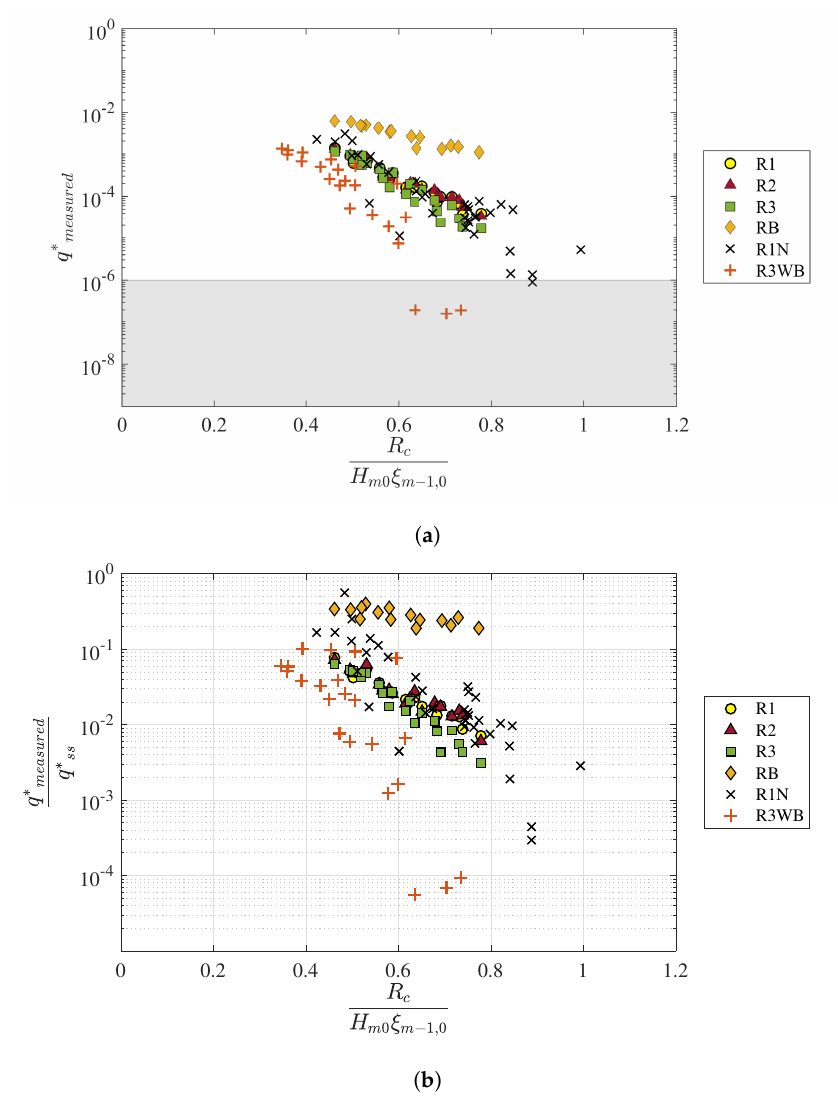
Figure 11. Experimental results of average overtopping discharge with ( a ) Overtopping data for all physical model tests and ( b ) Overtopping ratio of measured average overtopping discharge ( q ∗ at rough bermed slopes and overtopping discharge ( q ∗ overtopping Equations (A1) and